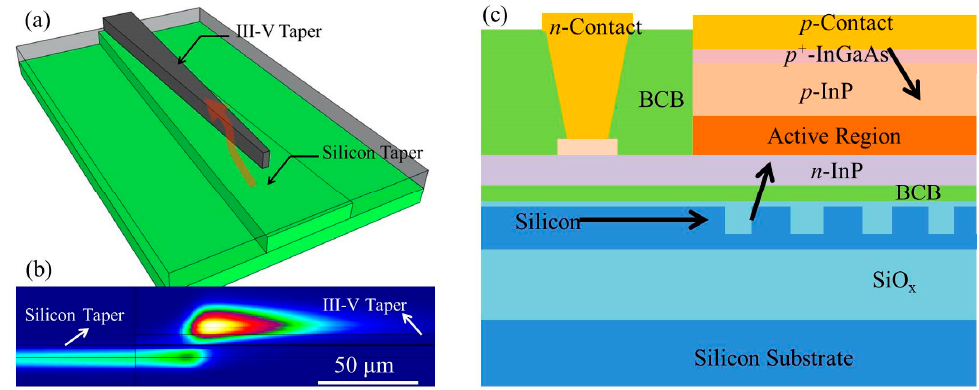
Figure 8. ( a ) Schematic of an adiabatically-coupled photodetector integrated on a silicon waveguide; ( b ) mode intensity distribution in a longitudinal cross section of the III–V/silicon taper taking the active region absorption into account; ( c ) schematic cross-section of a grating-assisted III–V-on-silicon photodetector.